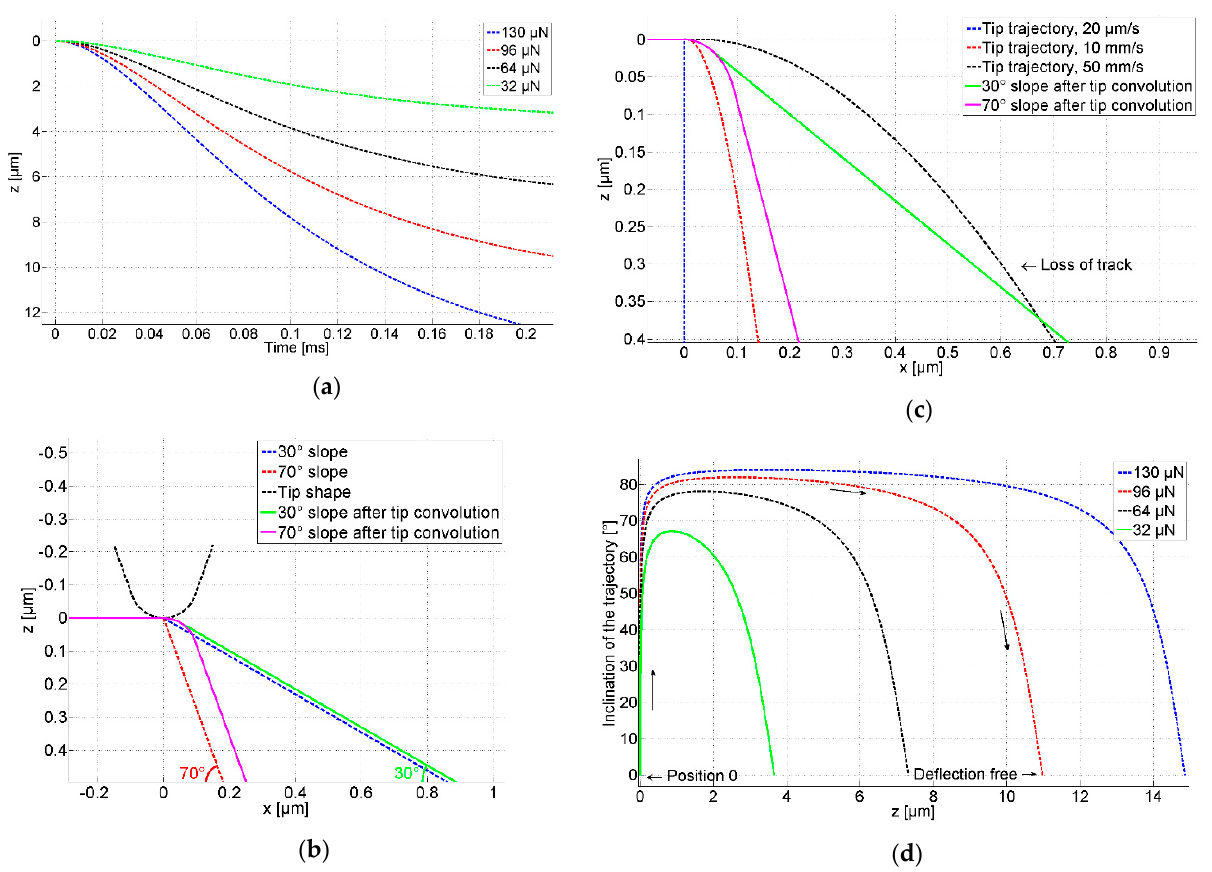
Figure 3. The dynamic behavior of the microprobe with a silicon tip. ( a ) The trajectory of the microprobe tip of the CAN50-2-5 drawing z with time under the condition of different initial probing forces; ( b ) The slope features before and after the tip convolution; ( c ) comparison of the tip trajectories and the slope features; ( d ) the steepest slope inclinations that the microprobe can track at the traverse speed of 10 mm/s.